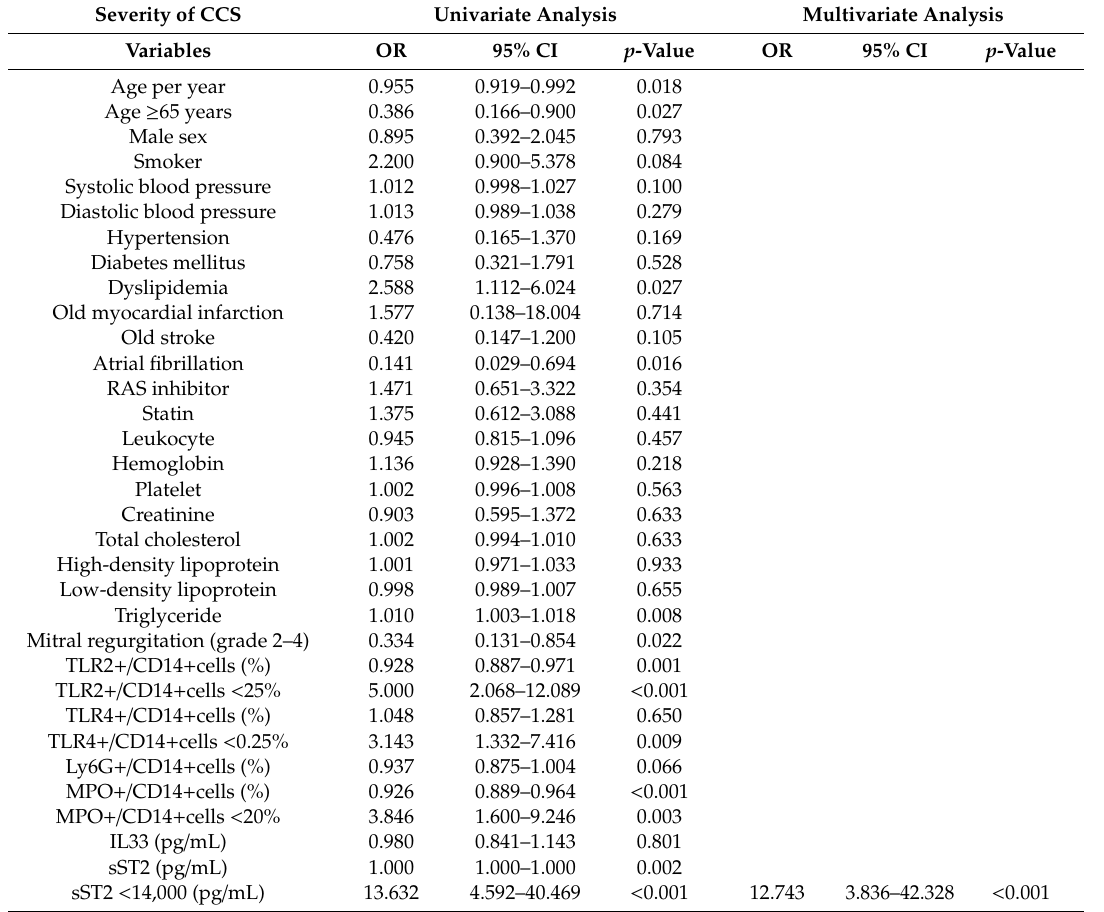
Table 4. Predictors of the mild CCS (NIHSS ≤ 8 and LVEF ≥ 60%).